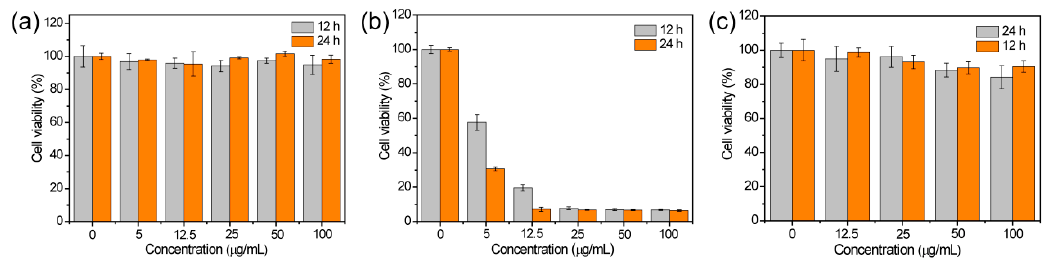
Figure 4. MTT assay of 4T1 cell viability after incubation of ( a ) Fe 3 O 4 -PAA, ( b ) Fe 3 O 4 -PAH and ( c ) Fe 3 O 4 -PVA at different concentrations of Fe for 12 and 24 h.